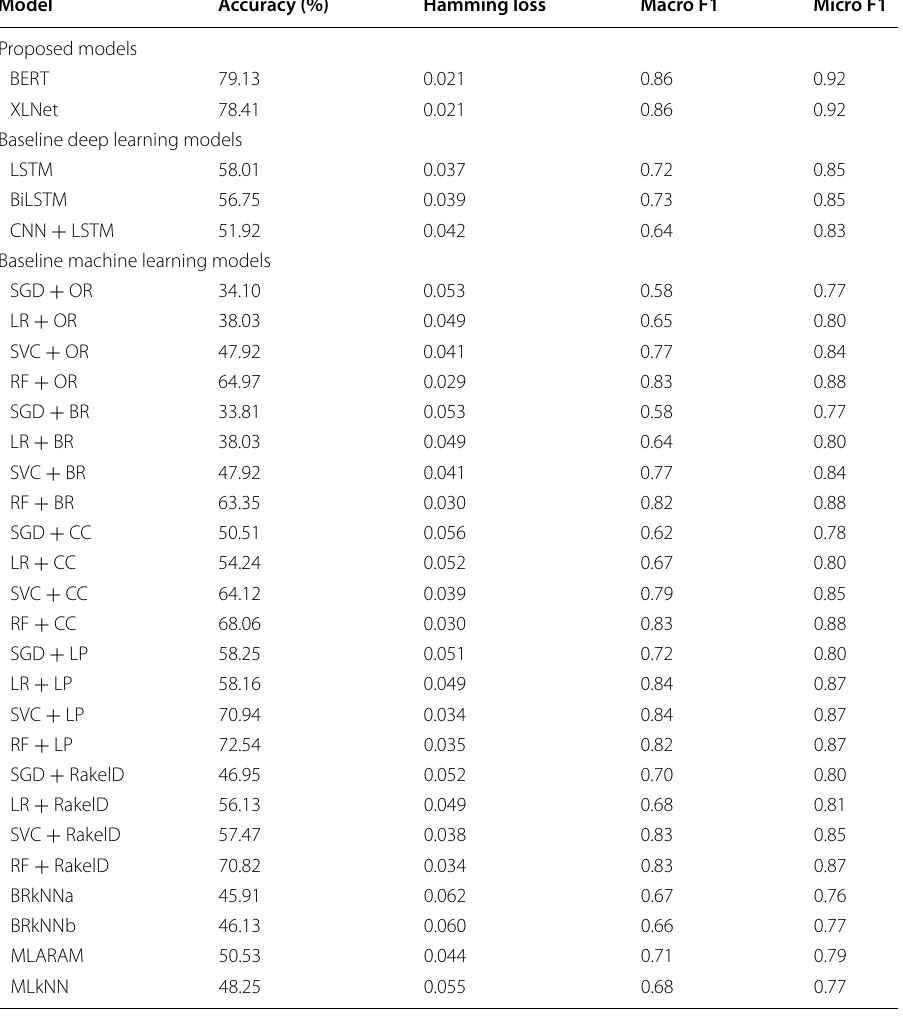
Table 10 Experiment results of wine reviews